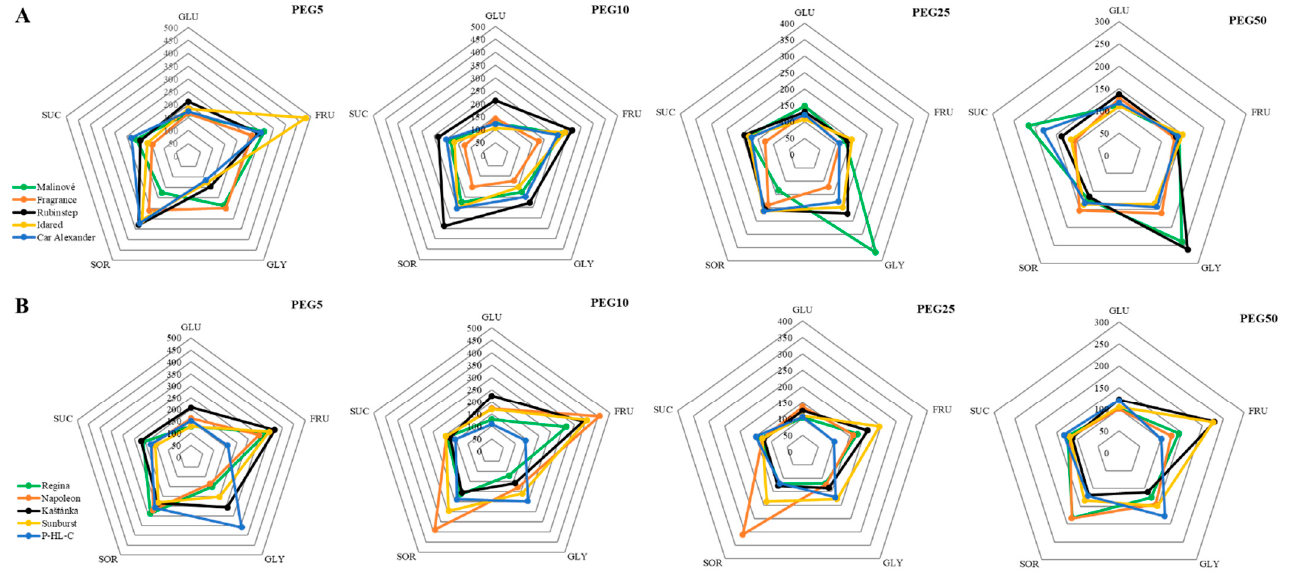
Figure 4. Effect of PEG-6000 concentration on sugars content (mg g − 1 FW) for in vitro culture of apple ( A ) and cherry ( B ) cultivars. All values were recalculated relative to the compound content in untreated samples taken as 100%. GLU, glucose; FRU, fructose; GLY, glycerol; SOR, sorbitol; SUC, sucrose. The statistical data are shown in Supplementary Material Tables S1 and S2.